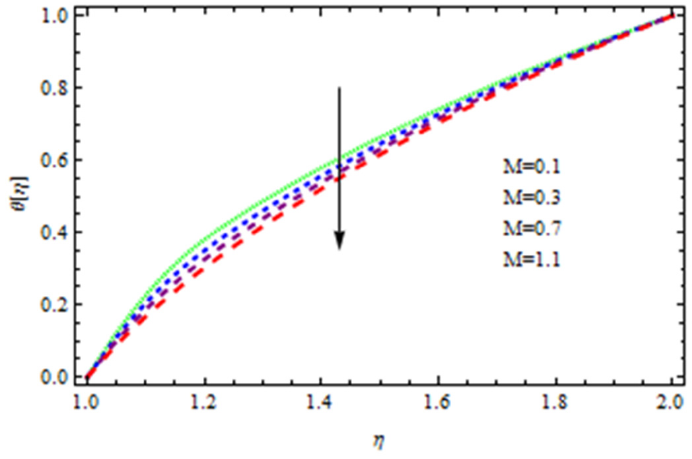
Figure 16. Temperature distribution in the Reynolds model for M.